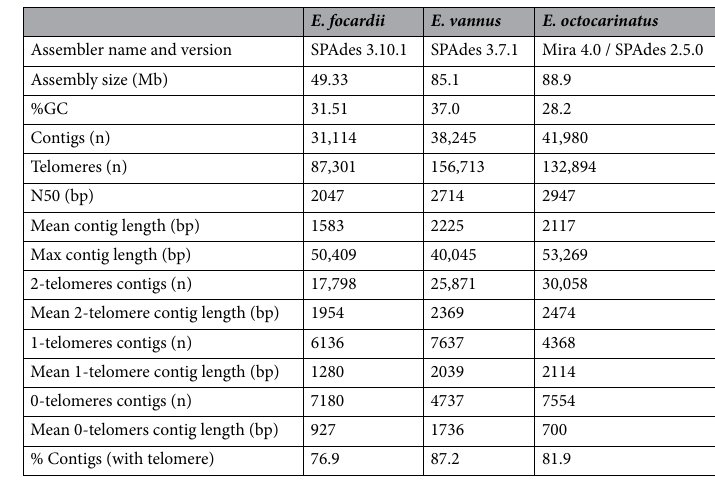
Table 1. E. focardii macronuclear genome assembly statistics in comparison with E. vannus 79 and E. octocarinatus 38